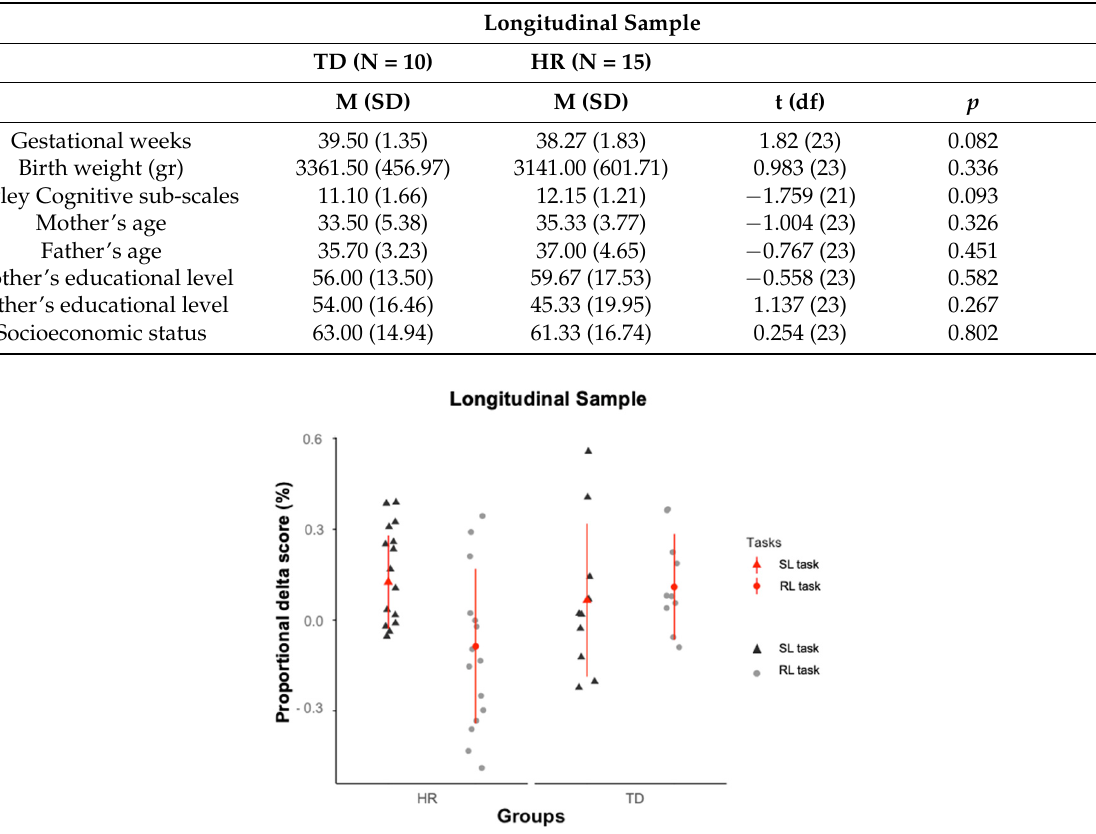
Figure 5. Individual data points of the proportional delta scores for the HR and the TD infants who participated in both SL and RL tasks. The red dots and lines represent, respectively, the group means